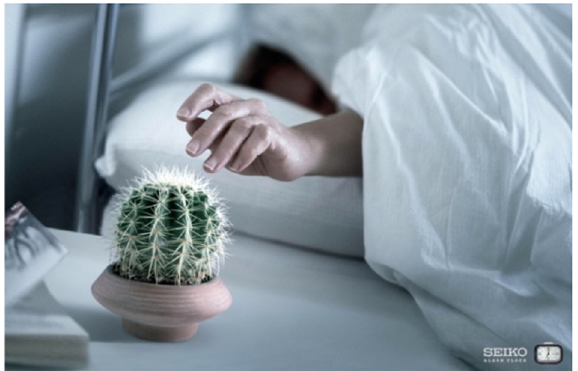
Fig. 7 Highlighted properties ( “ you want to describe ” ) are the relevant conceptual features.